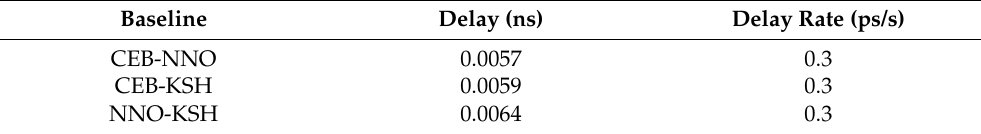
Table 4. Random error of observables of all the baselines.